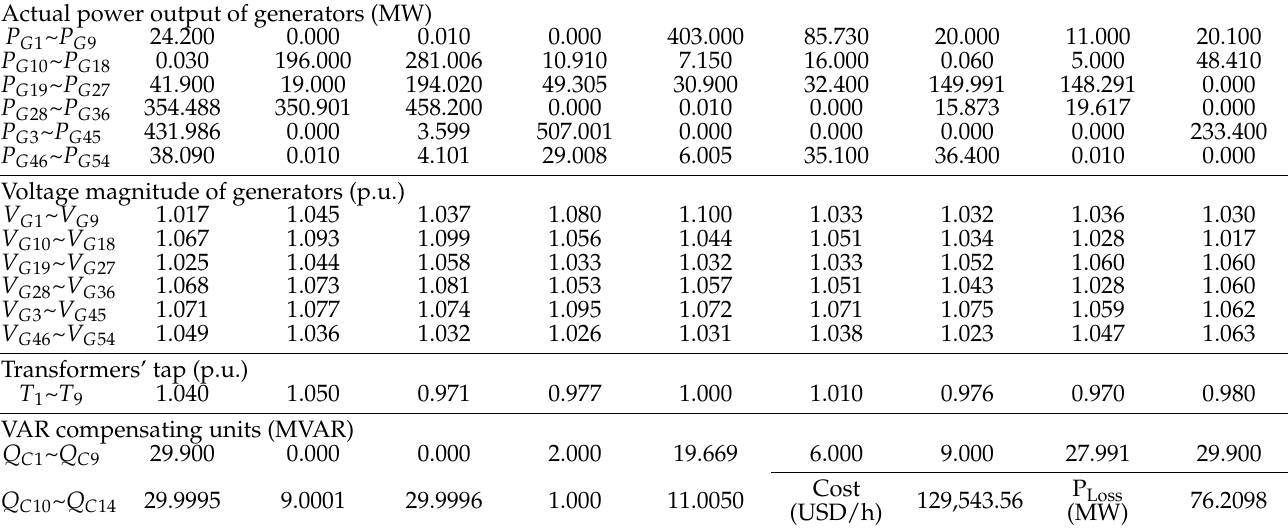
Table 16. Optimal decision variables settings for Case 12.